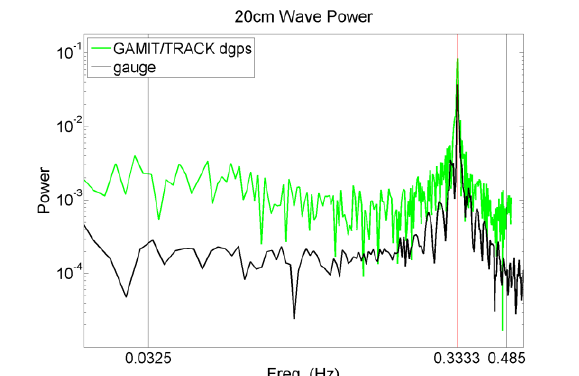
Figure 7(a). 20cm wave height FFT power spectrum